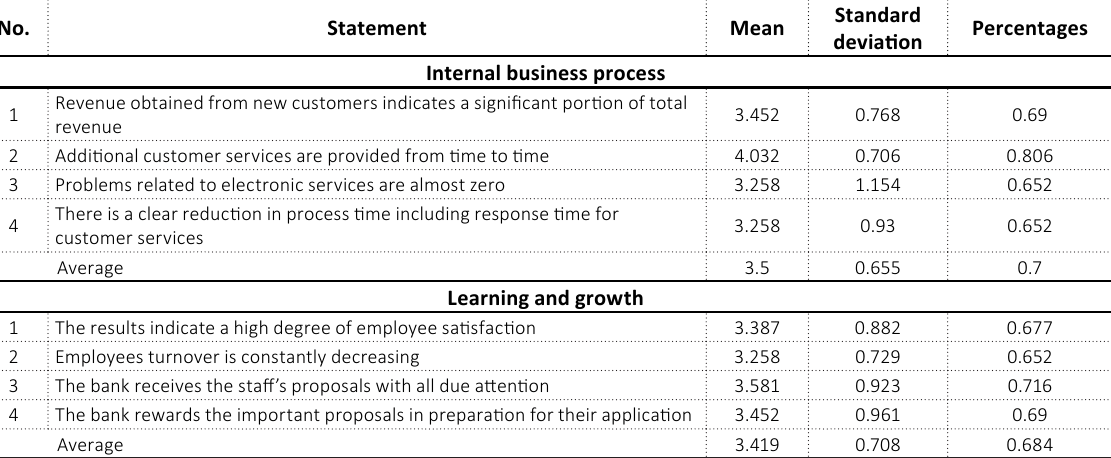
Table 4 (cont.). Descriptive statistics of responses for dependent variables (strategic performance) No.